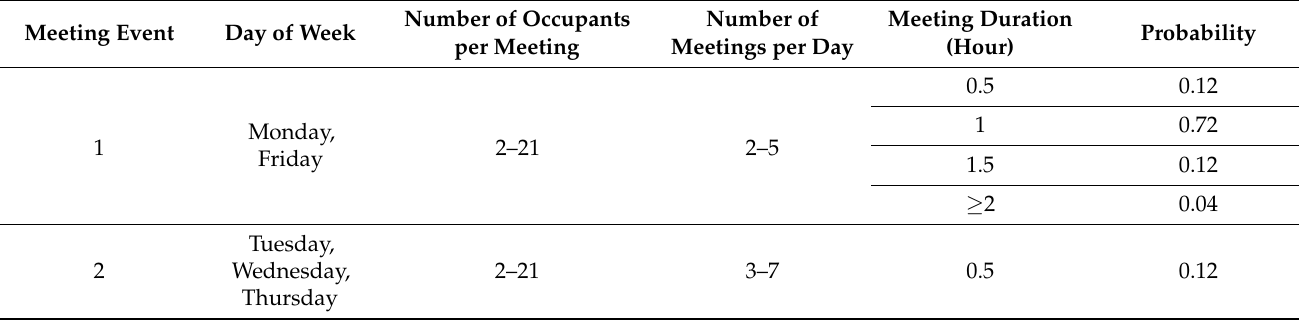
Table 3. The definition of the random movement event and status transition event.